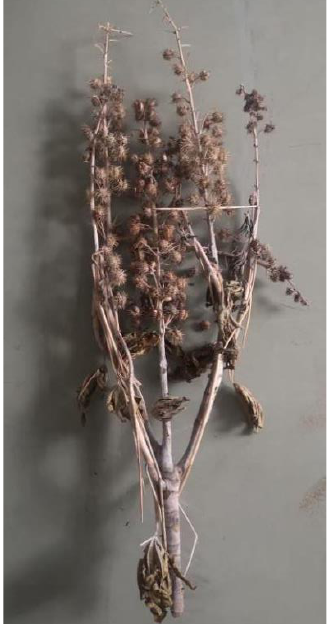
Figure 2. Castor stalk sample.